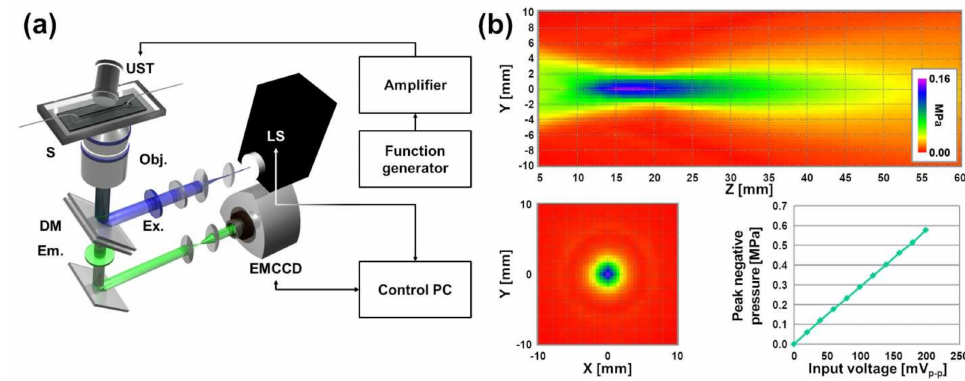
Figure 1. ( a ) Schematic of the optical imaging platform integrated with an ultrasound application system for obtaining fluorescence images of calcium flux changes and propidium iodide (PI) in a cervical cancer cell treated by ultrasound-microbubble cavitation. The meaning of each abbreviation in this figure is as follows. UST: an ultrasound transducer; S: a specimen that consists of a microfluidic cell culture flow chamber and a water tank; Obj.: an objective lens; DM: a dichroic mirror; Ex.: an excitation filter; Em.: an emission filter; LS: a light source for fluorescence excitation; EMCCD: an electron multiplying charge-coupled device camera. ( b ) Acoustic pressure fields ( xy and yz -axis) at an input voltage of 50 mV p-p and a graph of peak negative acoustic pressures via input voltages of a focused ultrasound